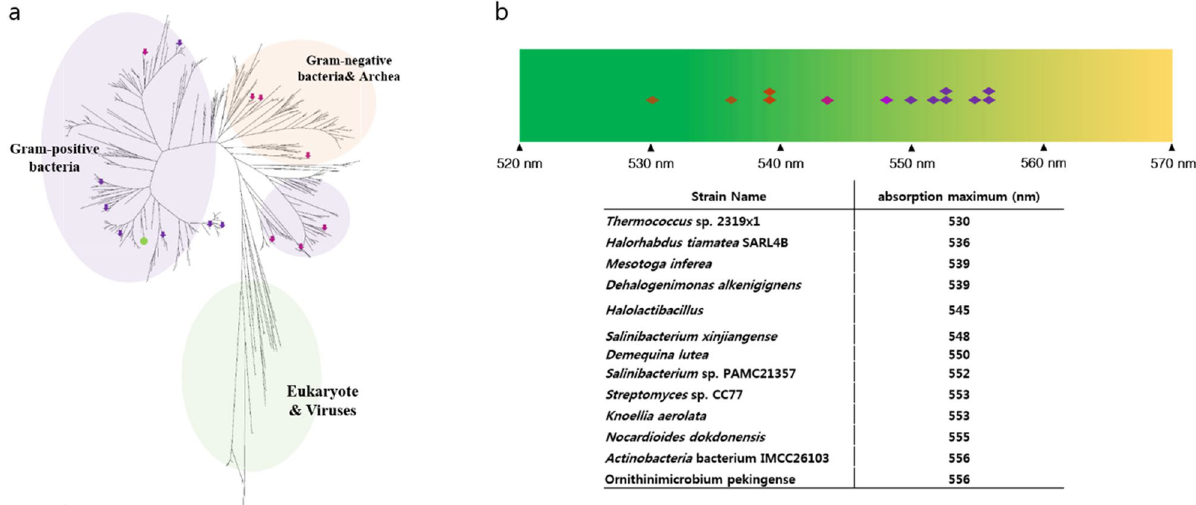
Figure 1. Phylogenetic tree and distribution of absorption maxima for various heliorhodopsins. ( a ) The phylogenetic tree is built with ~ 474 heliorhodopsins. Thirteen of them were selected from various microorganisms: Thermococcus sp. 2,319 × 1 (530 nm), Halorhabdus tiamatea SARL4B (536 nm), Mesotoga infera (539 nm), Degalogenimonas alkenigignes (539 nm), Halolactibacillus (545 nm), Salinibacterium xinjiangense (548 nm), Demiquina lutea (550 nm), Salinibacterium sp. PAMC21357 (552 nm), Streptomyces sp. CC77 (553 nm), Knoellia aerolata (553 nm), Nocardioides dokdonensis (555 nm), Actinobacteria bacterium IMCC26103 (556 nm), Orinithinimicrobium pekingense (556 nm). The arrows indicate the position of heliorhodopsins listed above, and the green circle is 48C12 HeR. Heliorhodopsins with λmax > 550 nm are marked in purple. The other heliorhodopsins are marked with pink arrows. There is a tendency for heliorhodopsins λmax > 550 nm exhibit close genetic distance. ( b ) Distribution of λmax values of various heliorhodopsins. Thirteen heliorhodopsin proteins were purified. 48C12 HeR is marked on the light spectrum. The color of the diamond represents the λmax of each HeR. In nature, the variation in λmax for heliorhodopsin is almost ~ 30